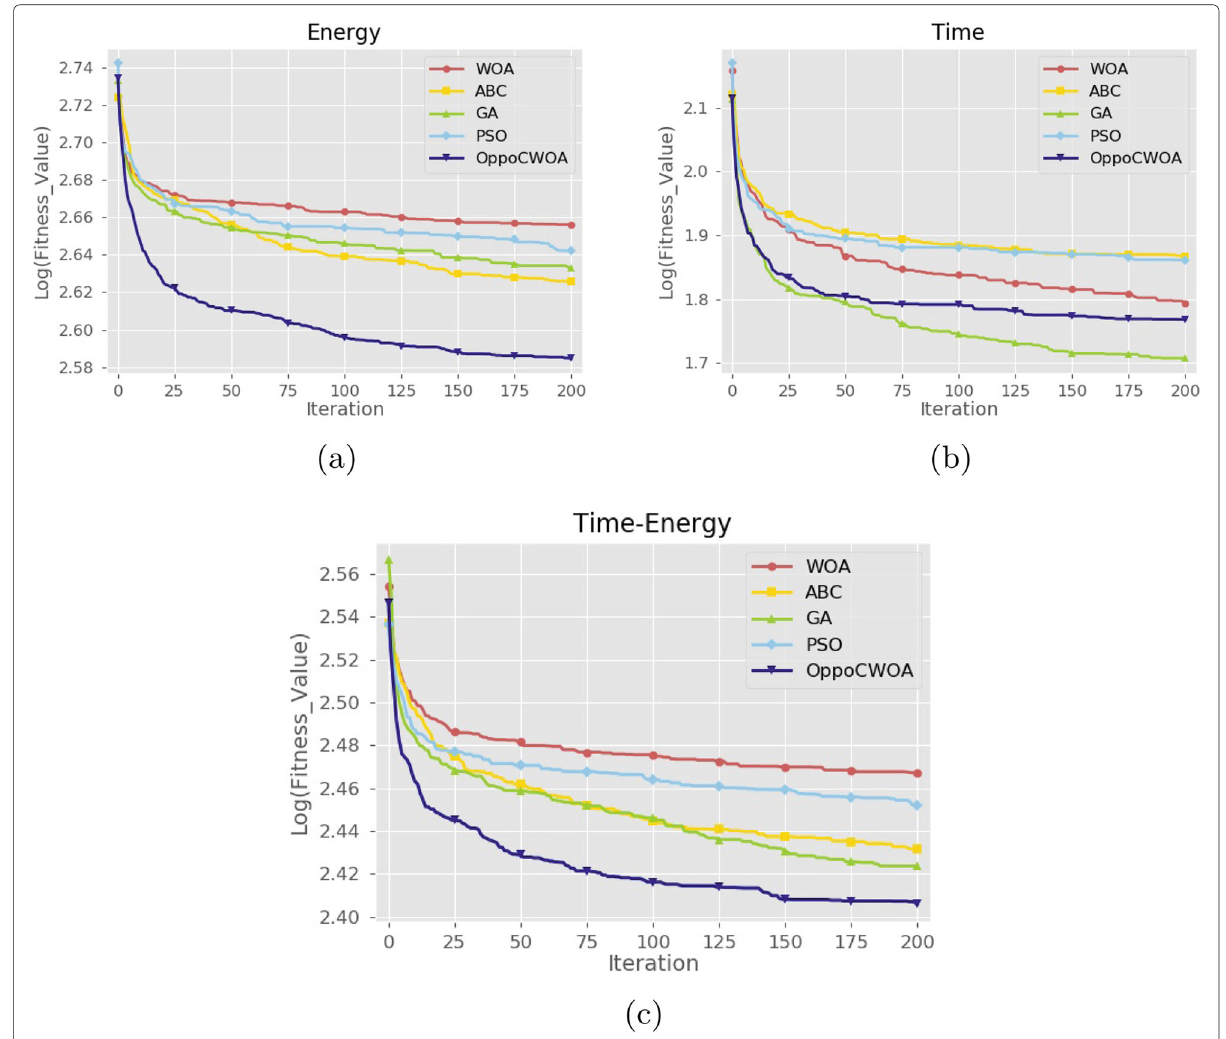
Fig. 12 Performance comparison of five algorithms with 50